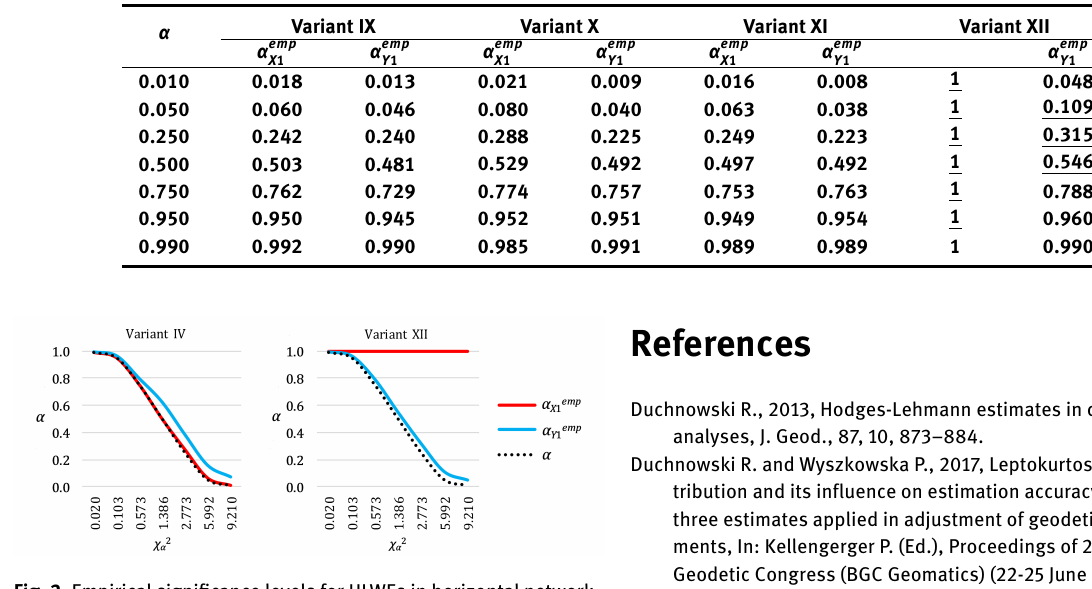
Table 6. Empirical significance levels α emp